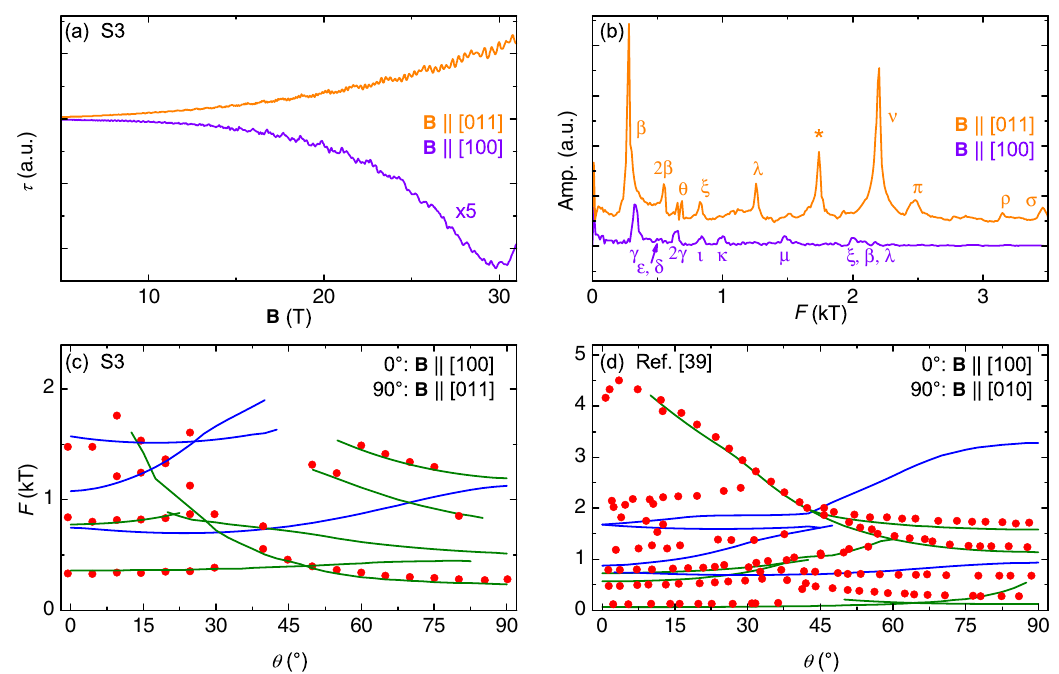
Fig. 6 Experimental-theoretical comparison of quantum oscillations. a Magnetic torque data taken at high fi eld on sample S3 for fi eld applied along raw data for B ∥ [011] (orange) and the a -axis (purple, amplitude increased fi ve times). b Quantum oscillation frequency spectra of the data in ( a ). Peaks marked with Greek letters correspond to those found at similar frequencies (±100 T) and the same angle in a prior quantum oscillation study 38 , using the notation of that work. A peak not identi fi ed in the previous study is labeled with an asterisk. c A comparison of observed fundamental quantum oscillation frequencies (red dots) to predicted electron (green lines) and hole (blue lines) band oscillation frequencies for E F = + 0.15 meV generated by SKEAF calculations for rotation between the angles in ( a ) and ( b ) of S3. d A comparison of SKEAF-generated frequencies from the same FS to data from Nozue et al. 38 for fi eld rotated between the a - and b